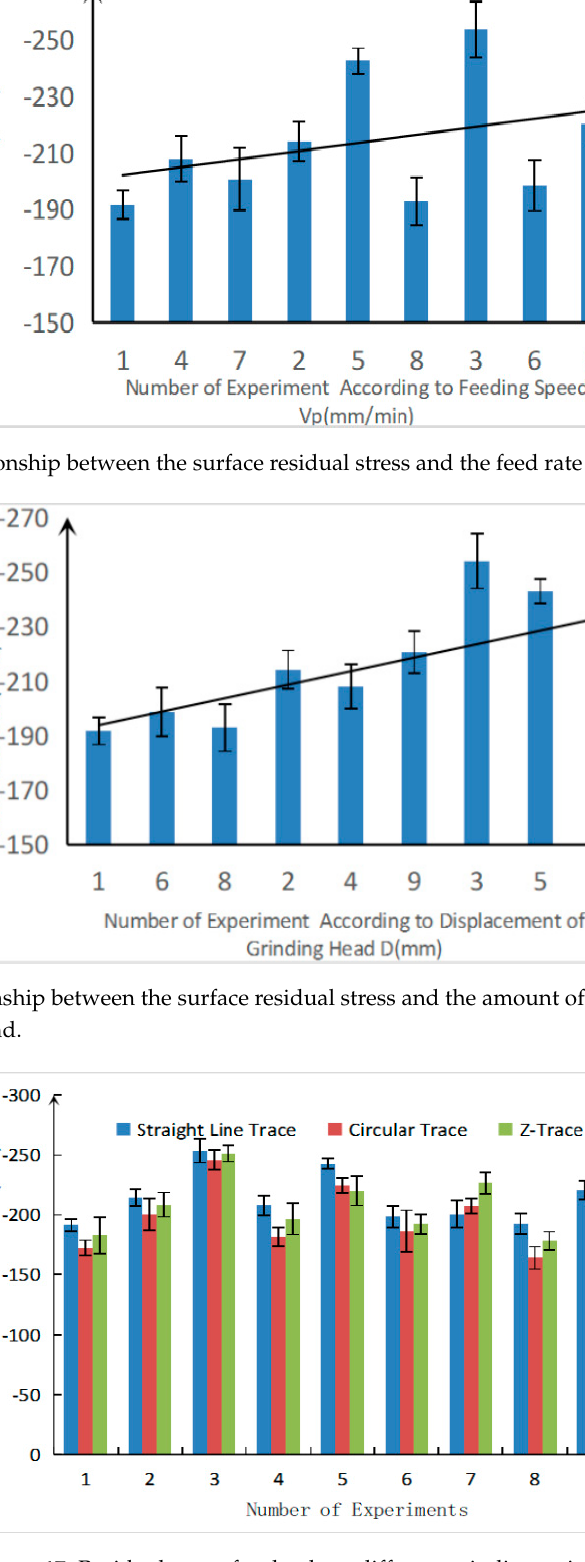
Figure 17. Residual stress for the three different grinding trajectories.